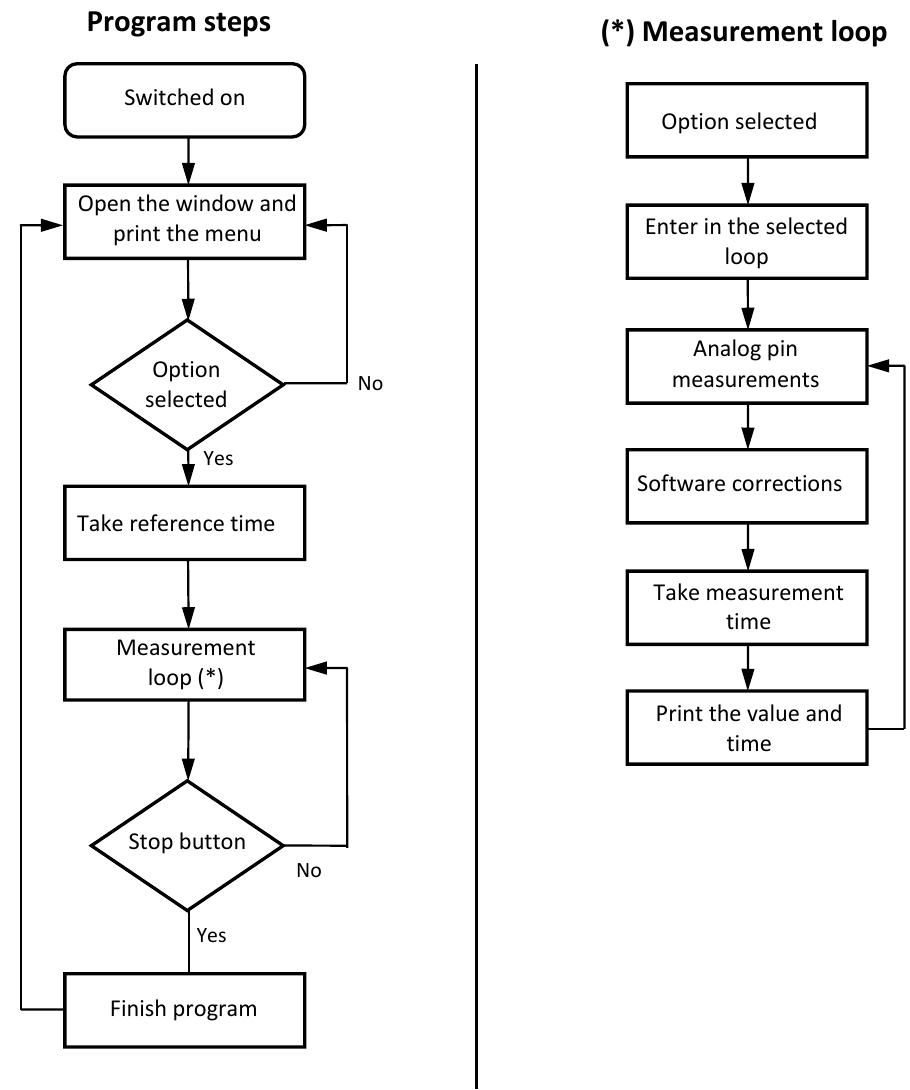
Figure 5. ABDAS software flowchart. Program steps and measurement loop.